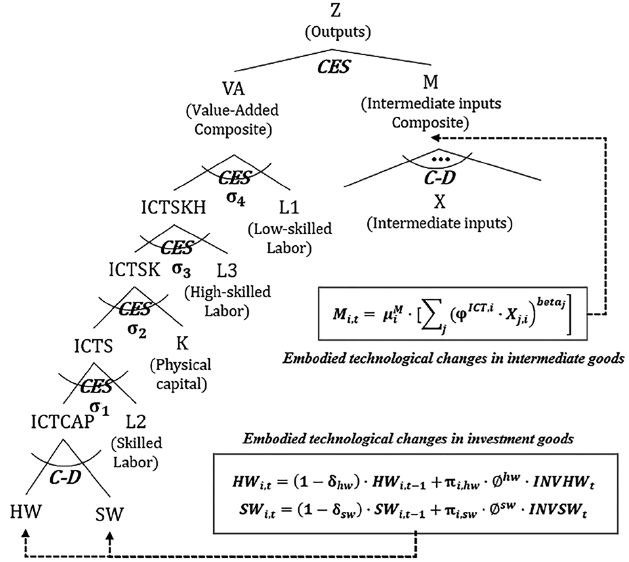
Figure 2. Descriptions of ICT technological